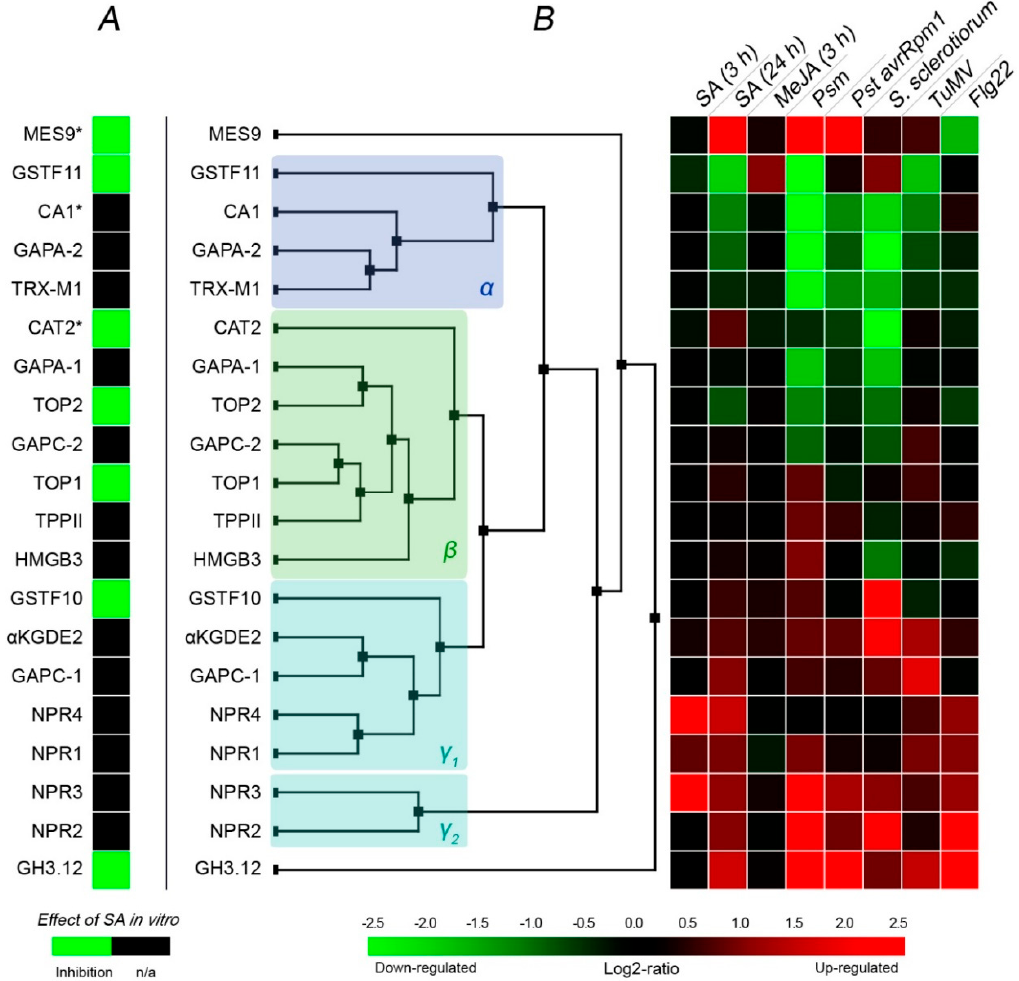
Figure 2. Effect of SA on the in-vitro catalytic activity of SABPs from A. thaliana ( A ) and transcriptional responses of corresponding coding genes ( B ). *, effect observed in tobacco orthologs. Transcriptomic data was mined using Genevestigator [95]. Experiment IDs: SA 3 h, AT-00113; SA 24 h, AT-00320; MeJA 3 h, AT-00110; Psm, AT-00406; Pst avrRpm1, AT-00106; S. sclerotiorum , AT-00681; TuMV, AT-00324; flg22, AT-00392. Note that the hierarchical clustering was performed on more experiments than the one used for the heat map (see the main text).